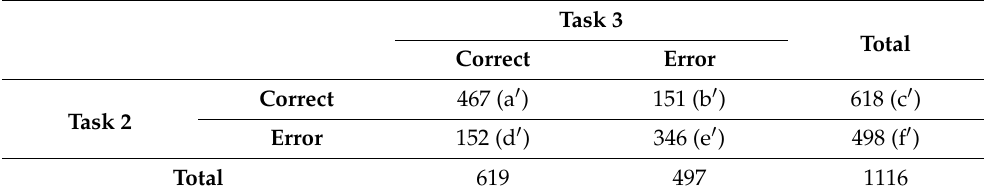
Table 7. Confusion matrix of tracking performance in incorrect case of Task